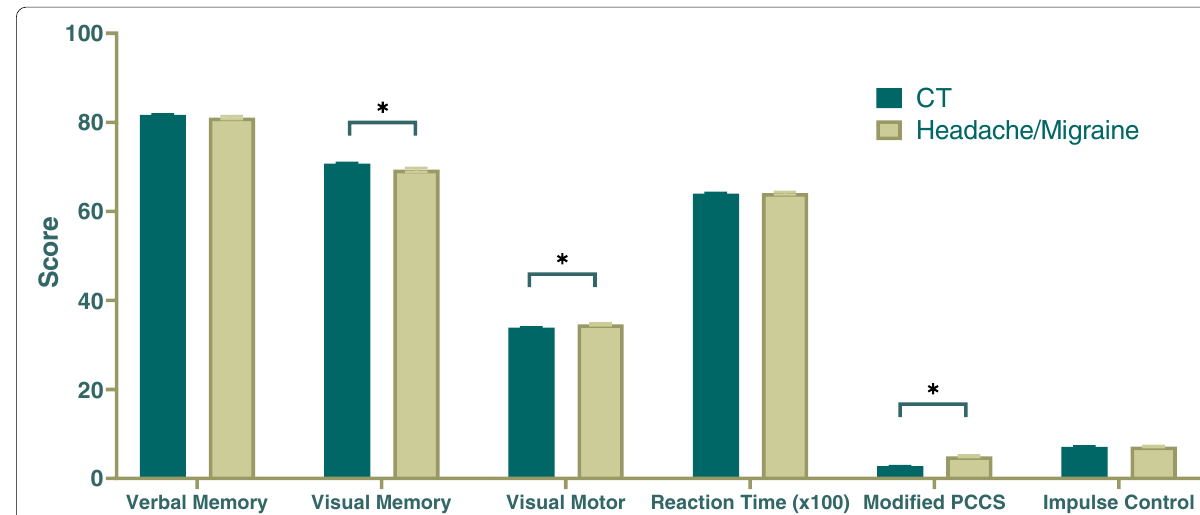
Fig. 1 Subjects with a history of treatment for headache and/or migraine had significantly decreased visual memory scores, increased visual motor scores, and greater symptom burden compared to controls. Asterisks indicate significant